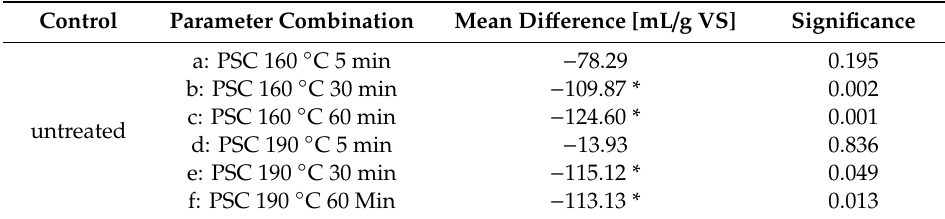
Table 2. Significance test for BMP.